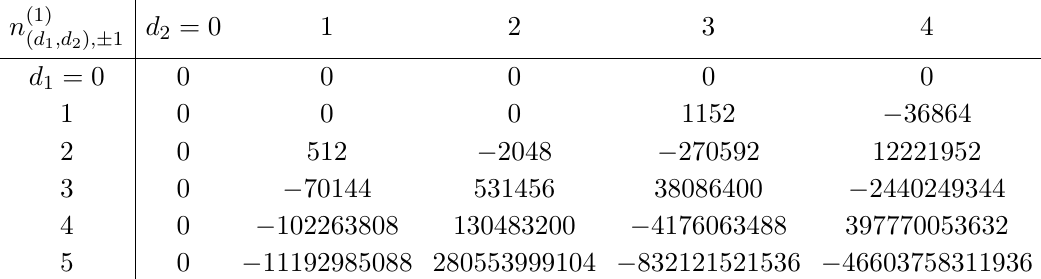
with Z charge ± 1 . 4 0